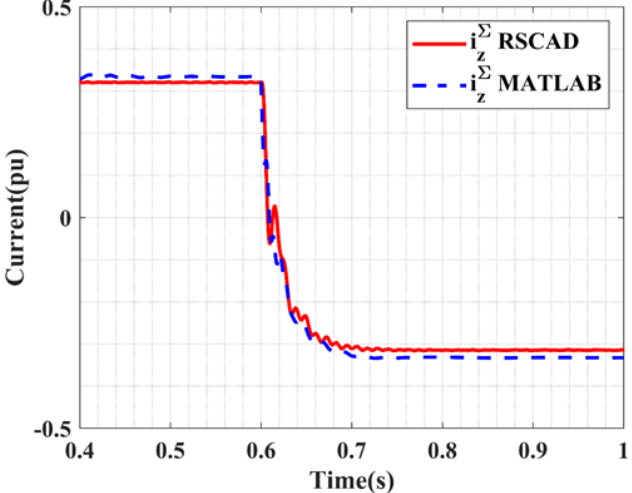
Figure 12. Comparison of zero sequence circulating current i Σ z in MATLAB (blue) and RSCAD (red), during active power reversal from 1 p.u. to -1 p.u. at the time instance t = 0.6